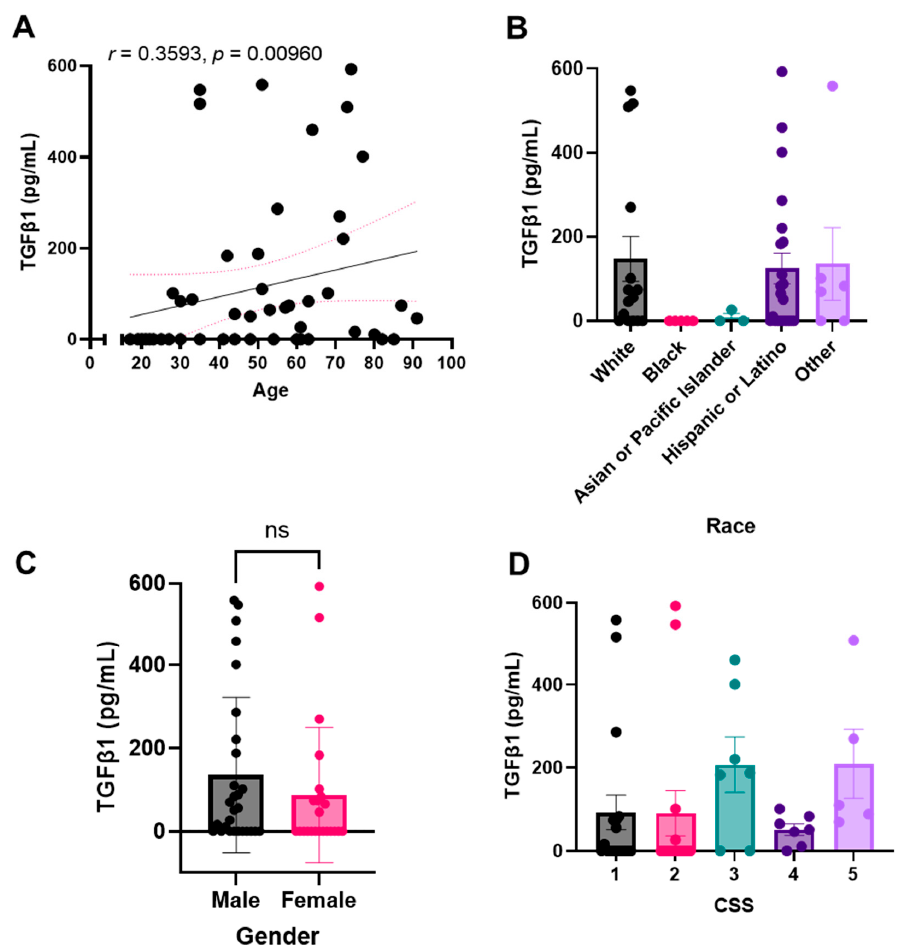
Figure 4. Active plasma TGF- β 1 levels correlate with total TGF- β 1 levels. Active TGF- β 1 levels were detected in non-activated plasma samples. TGF- β 1 plasma concentration correlation with ( A ) age, ( B ) race, ( C ) sex, or ( D ) COVID-19 severity score (CSS). Sample values are reported in pg/mL (n = 81 samples). Statistical significance was calculated using: ( A ) Spearman’s correlation, ( B , D ) One- way Anova followed by a post hoc Tukey’s multiple comparisons test, and ( C ) two-tailed, unpaired Student’s t-test. Bar graphs represent the mean of the population, and error bars indicate standard deviation. The minimal level of significance was p < 0.05.